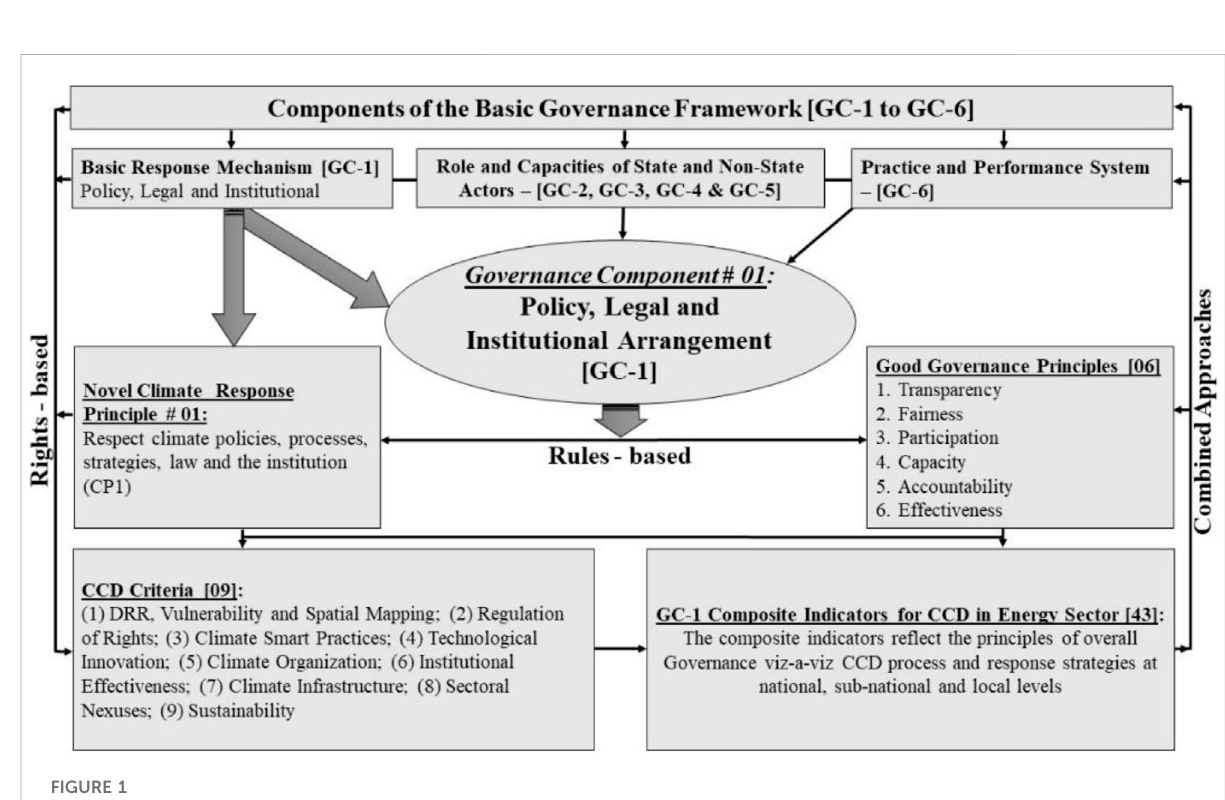
FIGURE 1 GC1 CCD assessment model for energy